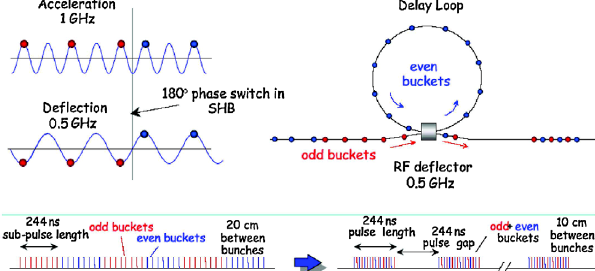
FIG. 7. Principle of operation of the CLIC recombination scheme [12].